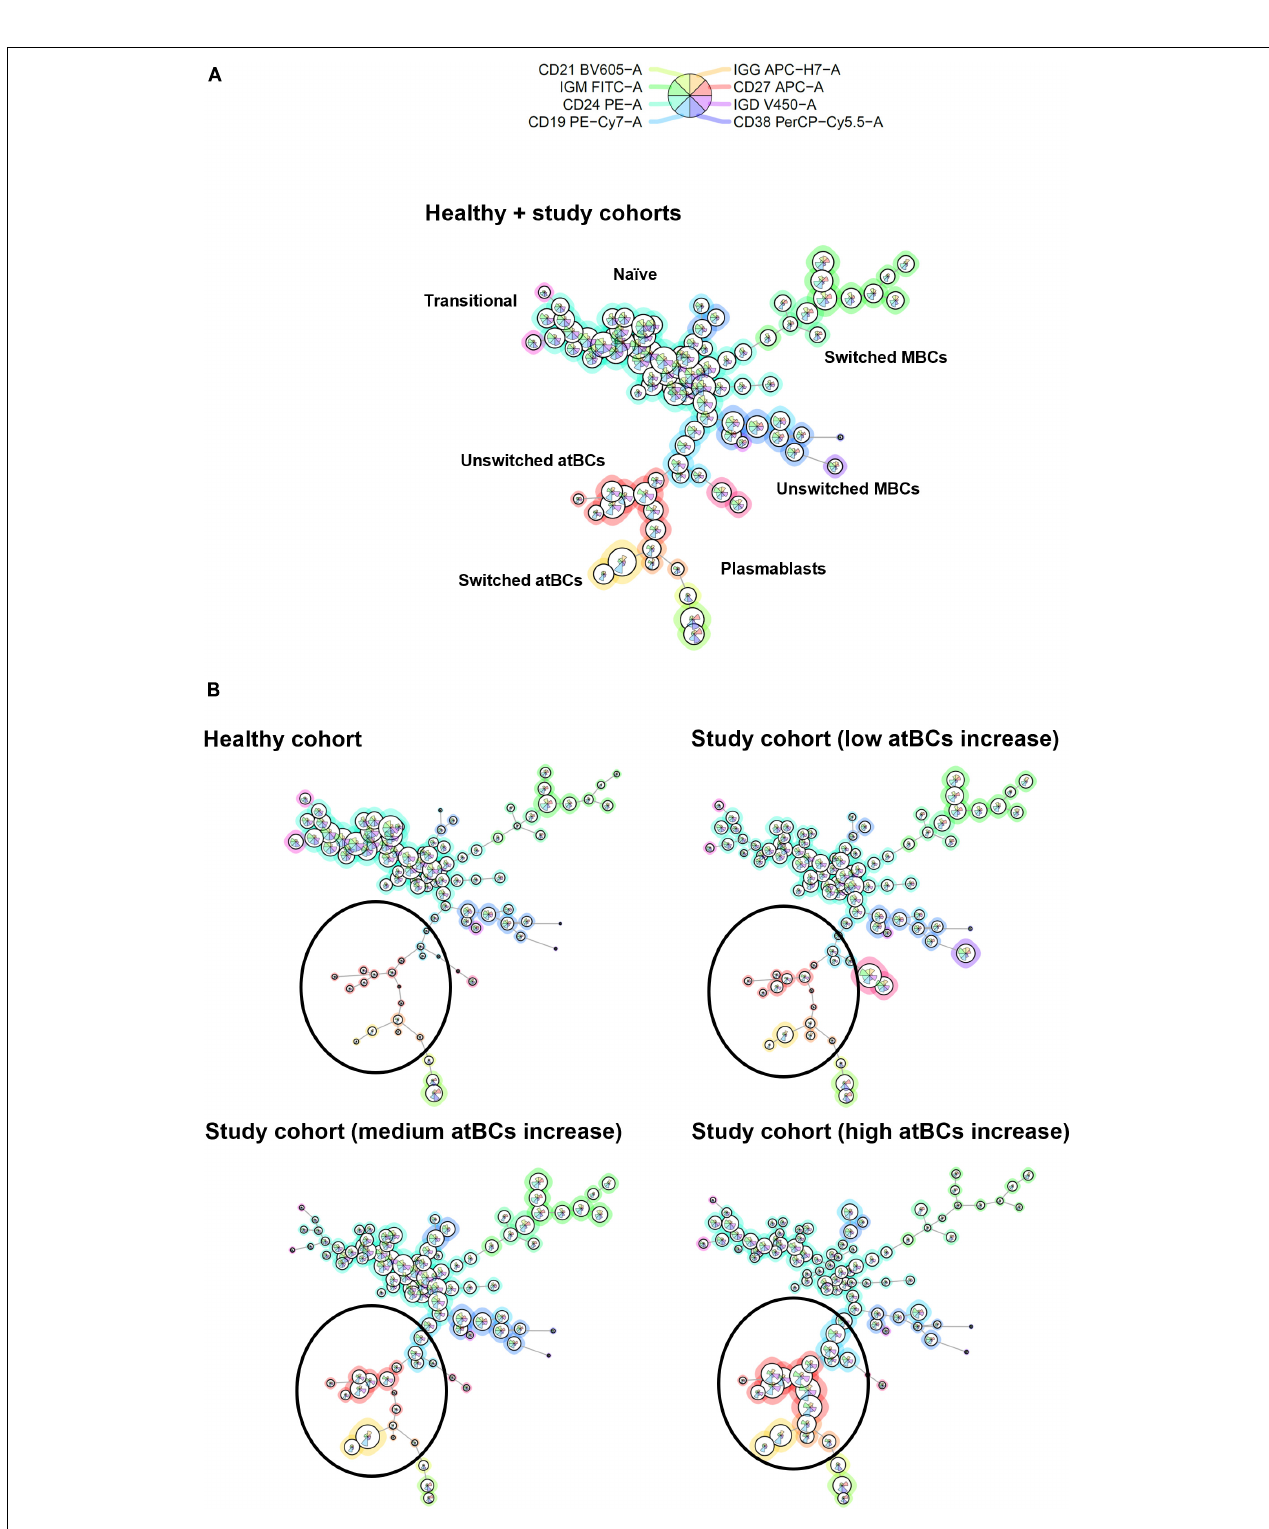
FIGURE 6 | B-cell subsets clustering by FlowSOM star charts. (A) Thirty patients from the study cohort (low atBCs increase, n = 10; medium atBCs increase, n = 10; high atBCs increase, n = 10) and 10 healthy controls were selected for a graph-based clustering analysis, using flow cytometric Self-Organizing Map (FlowSOM). (B) Star chart of all 40 patients. The background coloring of nodes indicates the clustering. Definitions of the different B-cell subsets are shown for each clustering. Comparison by FlowSOM star charts of healthy group and the three classes of patients with increased atBCs (low, medium, and high). Black circles highlight atBCs